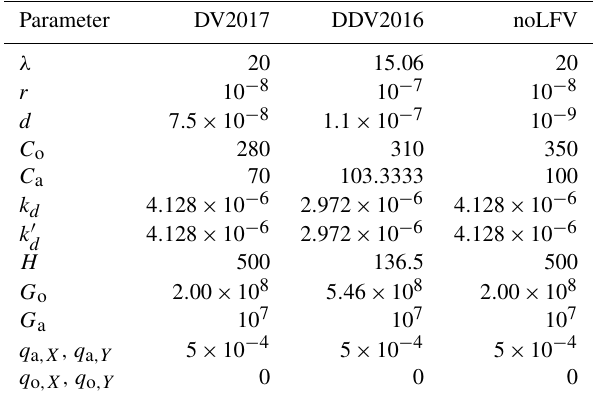
Table 1. The main parameters used in the parameterization experi- ments. For a description of the parameters, see De Cruz et al. (2016) and Demaeyer and Vannitsem